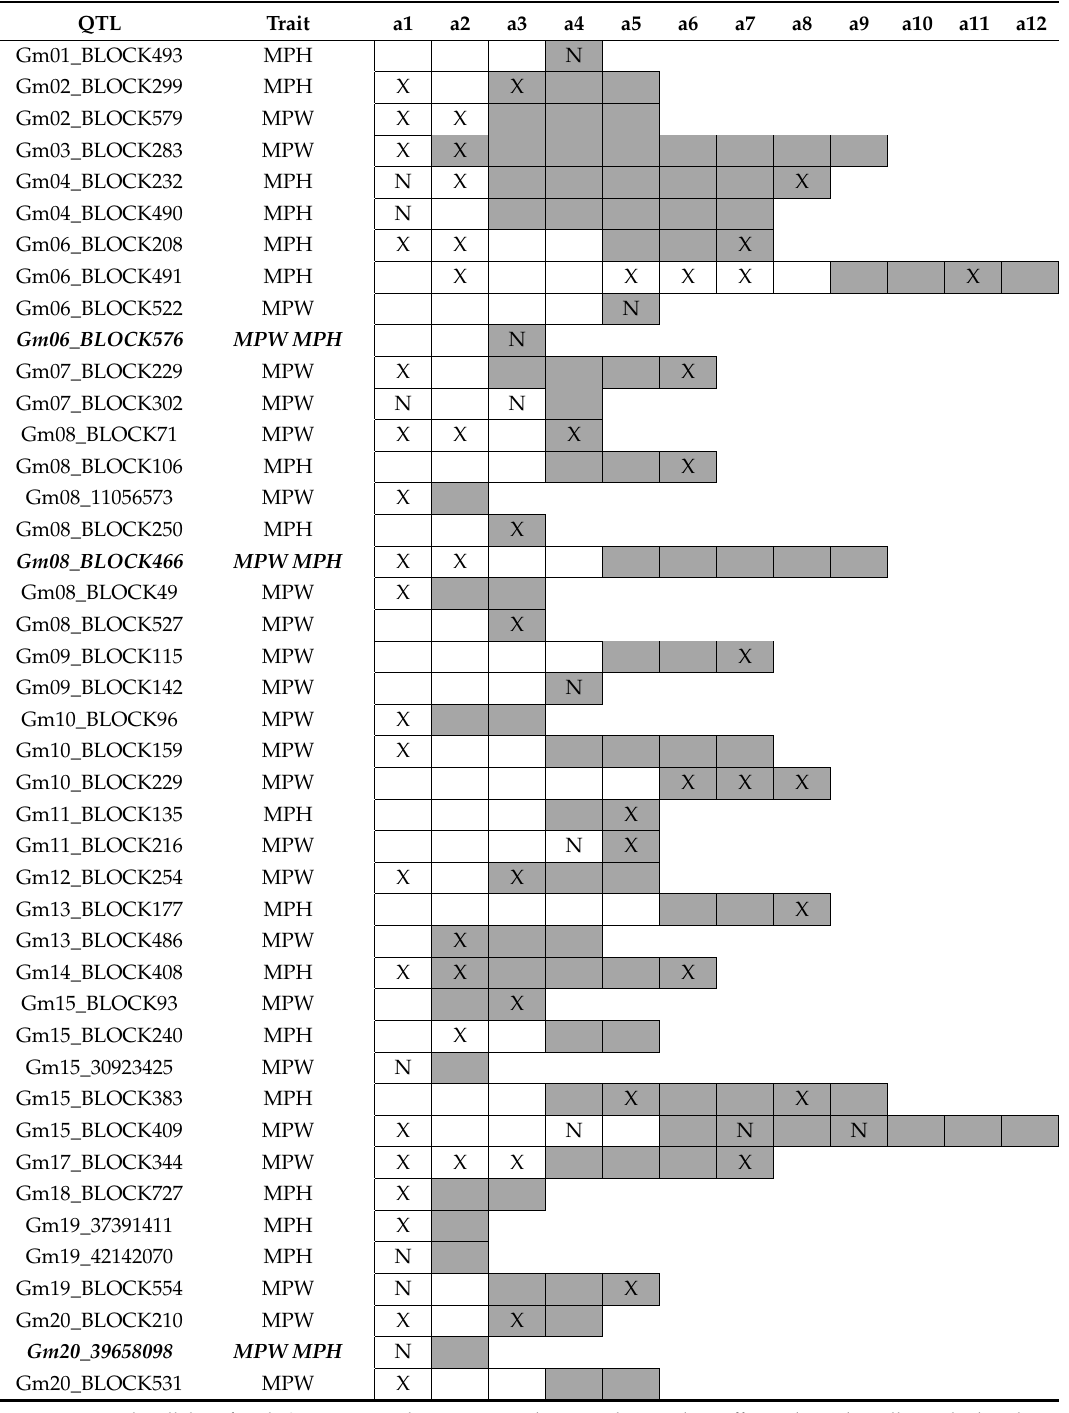
Table 5. Alleles changed from landrace subpopulation to released cultivar